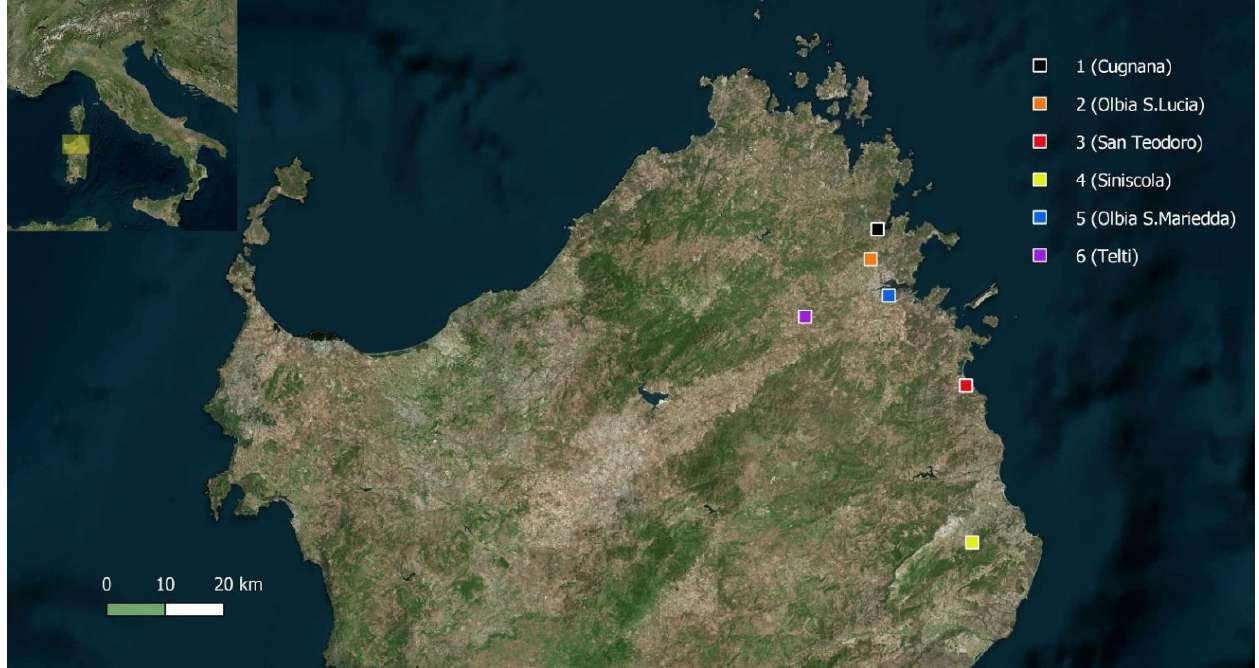
Figure 1. Map of the study area and location of nest sites.